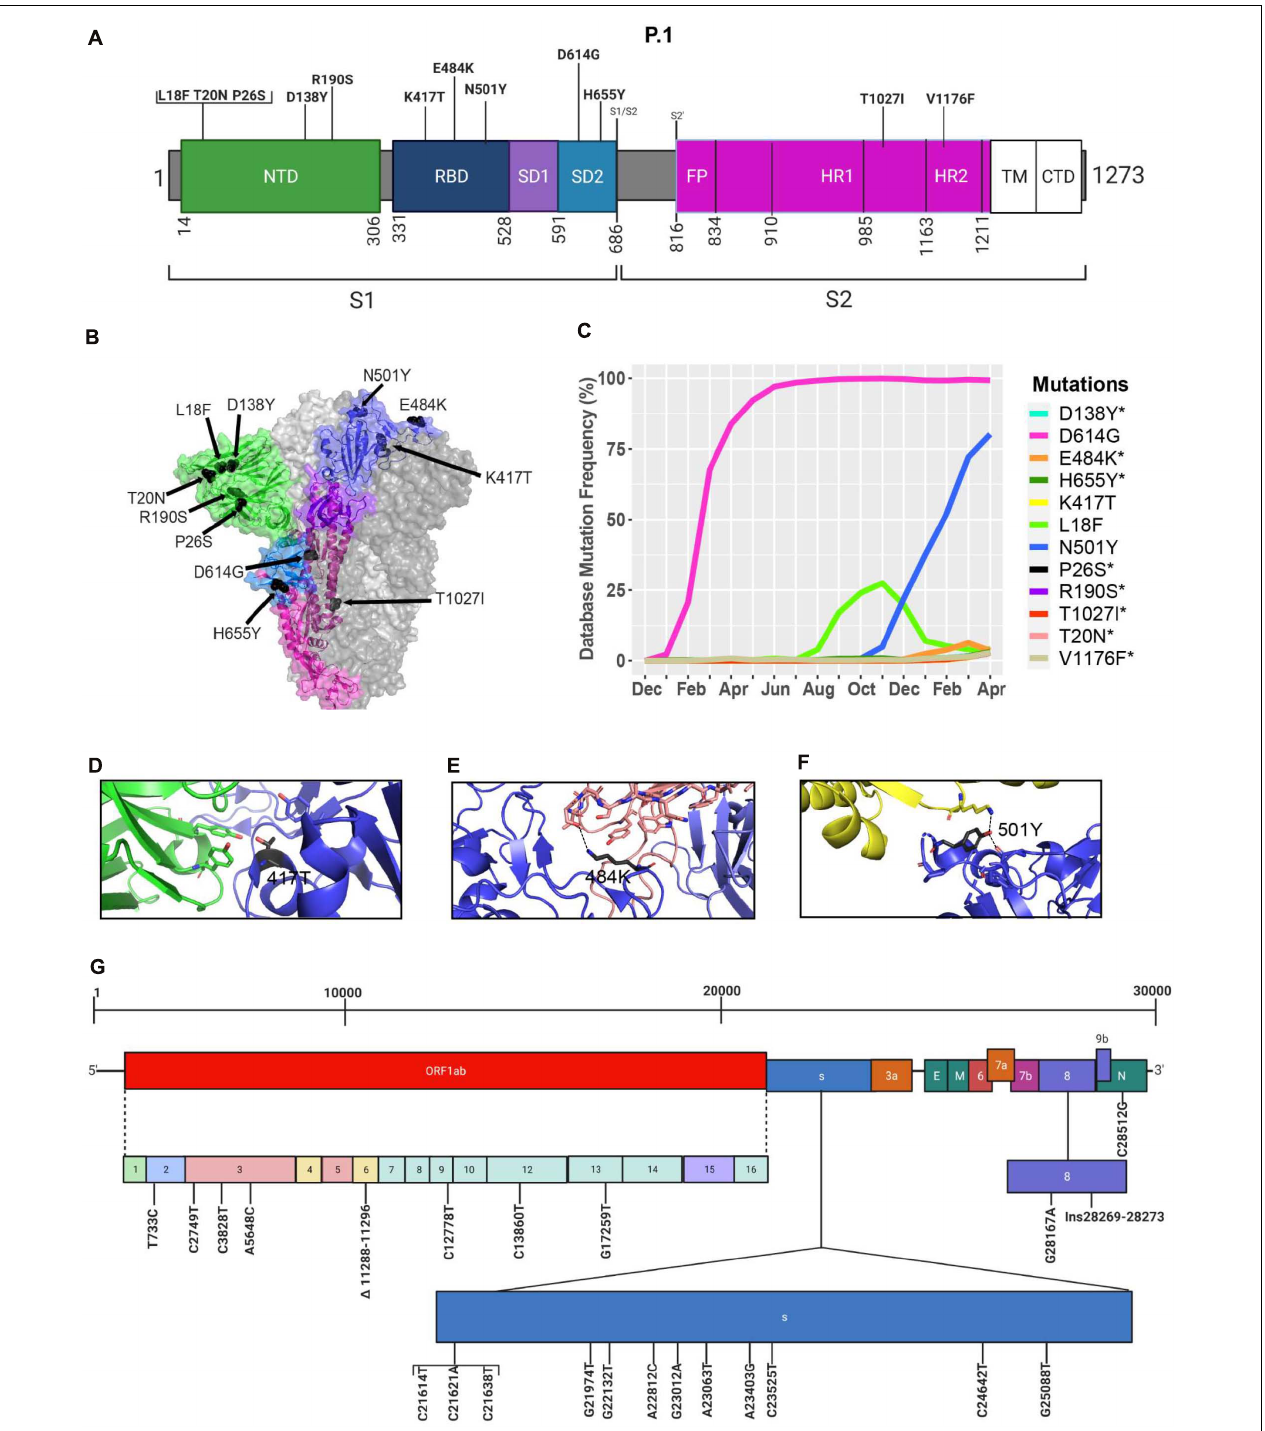
FIGURE 8 | Analysis of mutations in the P.1 variant. (A) Mutation map of the spike protein of P.1. (B) Structural representation of spike with ACE2. P.1 S protein mutations are presented in black. NTD (green), RBD (blue), SD1 (purple), SD2 (light blue), and S2 (magenta) are illustrated. The other S protein monomers are illustrated in gray and white. (C) Frequency of P.1 variant S protein mutations from December 2019 to April 30, 2021. Interaction of (D) 417T with C102 Nab (green), (E) 484K with C121 Nab (light pink), and (F) 501Y with hACE2 (yellow). The mutations are colored in black and interaction with adjacent residues are demonstrated by dashed lines. (G) Genome of the SARS-CoV-2 P.1 variant with identified nucleotides substitution, deletions, and insertions. Figures were generated using Biorender, PyMOL, and RStudio. *Overlapping curves.